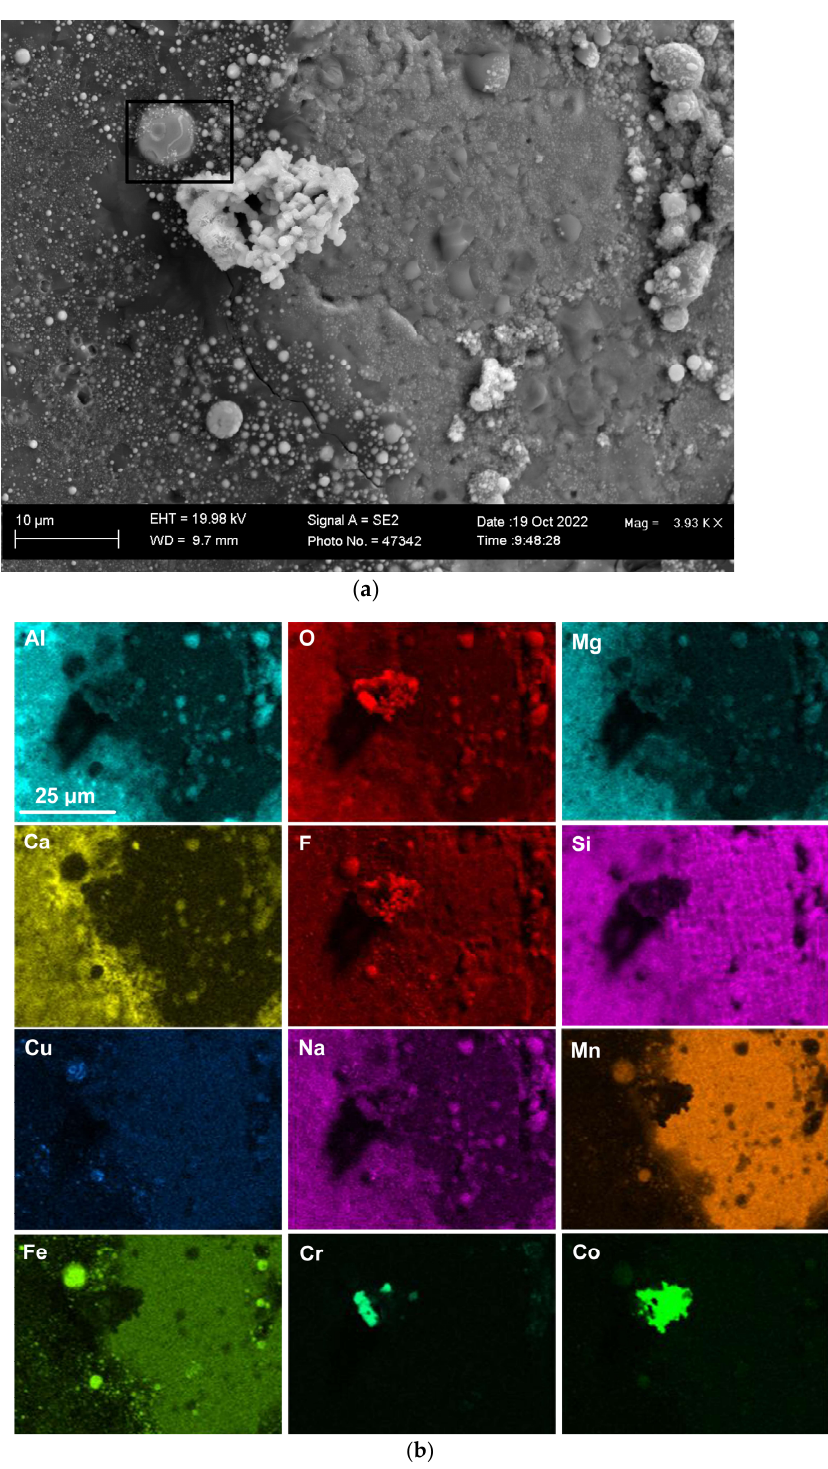
Figure 5. ( a ) BSE image at 3930× magnification showing 3D structures in slag dome in the MP11 post-weld slag, as shown in Figure 4a’s blocked area; ( b ) EDX maps of the FOV (field of view) in Figure 5a.